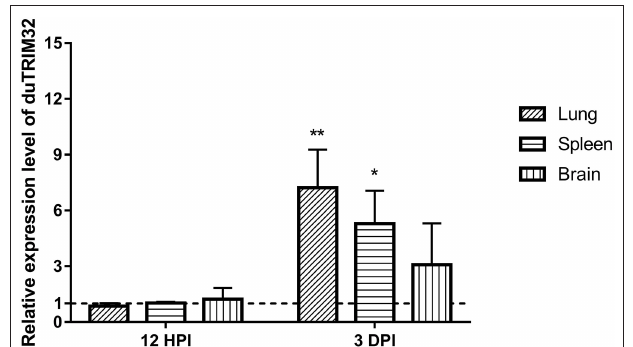
FIGURE 4 | Relative expression levels of duTRIM32 in the lungs, spleens and brains of DK16873 H5N6 HPAIV infected ducks were quantified by real-time RT-PCR. The experimental ducks were inoculated with 10 6 EID 50 of DK16873 H5N6 HPAIVs. Control ducks were treated with PBS in the same way. Each bar shows the mRNA level of the target gene relative to those in the control group. All data were expressed as means ± SD, the Student’s t -test was used to analyze the differences. (* p < 0.05; ** p < 0.01).